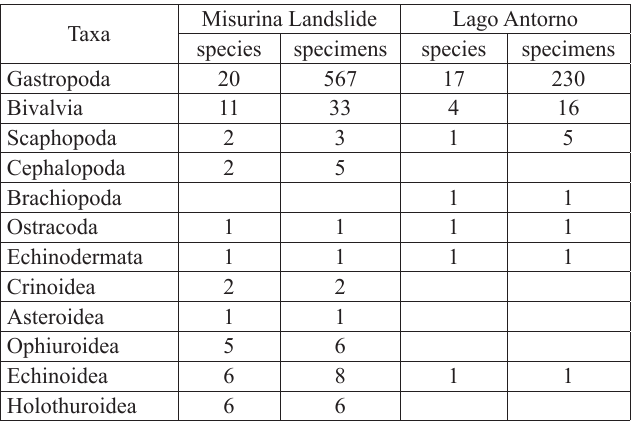
Fig. 2. Species (A 1 , B 1 ) and specimen (A 2 , B 2 ) proportions within higher taxa of the bulk samples from Misurina Landslide ( A ) and Lago Antorno ( B ). Table 2. Number of species and specimens per higher taxon in the Misurina Landslide and Lago Antorno bulk samples.